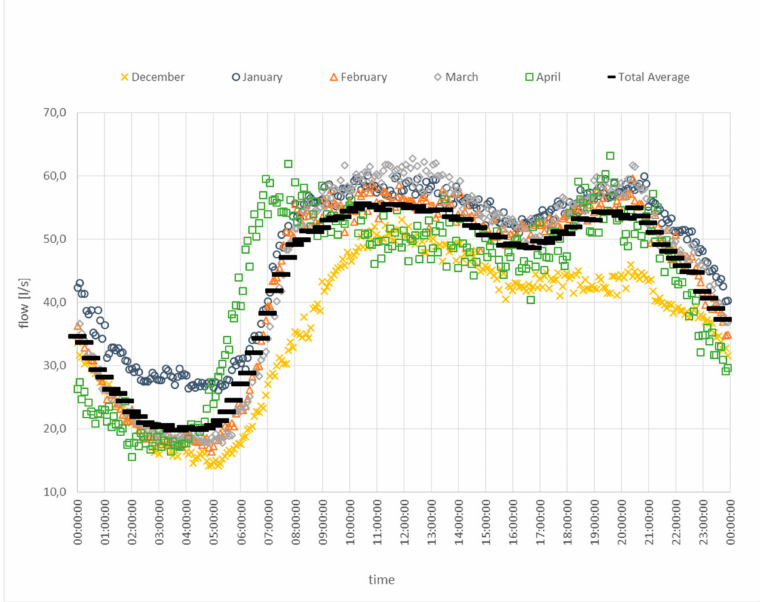
Figure 4. Monthly and total average dry weather wastewater flow from December 2015 to April 2016.